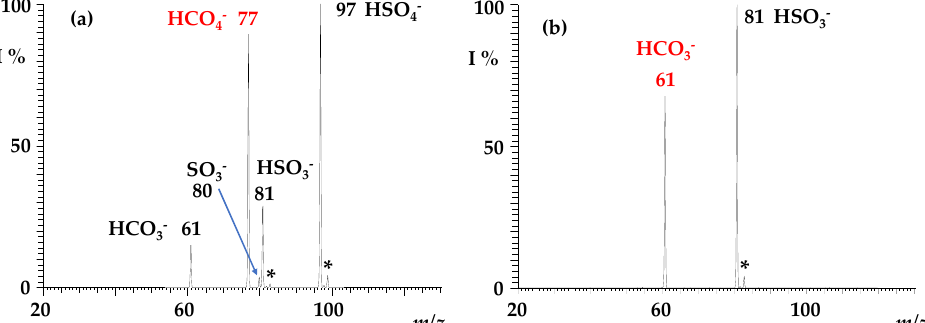
Figure 2. ITMS spectrum showing ( a ) the ion–molecule reaction of isolated HCO 4 − ions ( m/z 77) with SO 2 , reaction time = 200 ms, P SO 2 = 1.3 × 10 − 7 Torr. Observed products: HSO 4 − at m/z 97, HSO 3 − at m/z 81, HCO 3 − at m/z 61; the signals denoted with * correspond to H 34 SO 3 − ( m/z = 83) and to H 34 SO 4 − ( m/z = 99); ( b ) the ion – molecule reaction of HCO 3 − ions ( m/z 61) isolated from the sequence 77 → 61 with SO 2 (reaction time = 200 ms, P SO 2 = 1.3 × 10 − 7 Torr), showing that HSO 3 − at m/z 81 is formed from a consecutive reaction. The signal denoted with * at m/z 83 corresponds to H 34 SO 3 − .